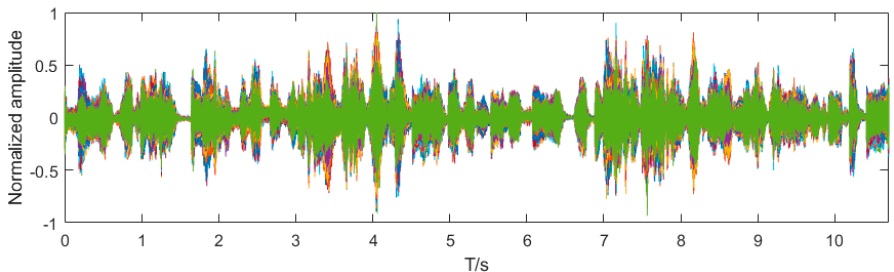
Figure 13. Forty − channel measured mixed signal in the experimental study.